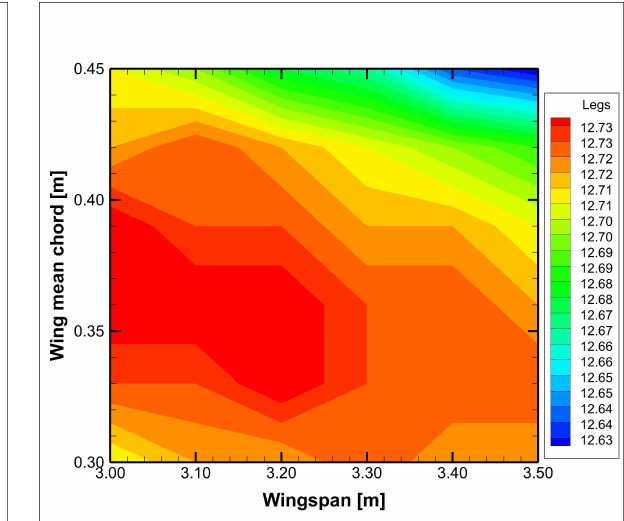
Figure 12: Payload weight [N] as a function of wingspan and wing mean chord.